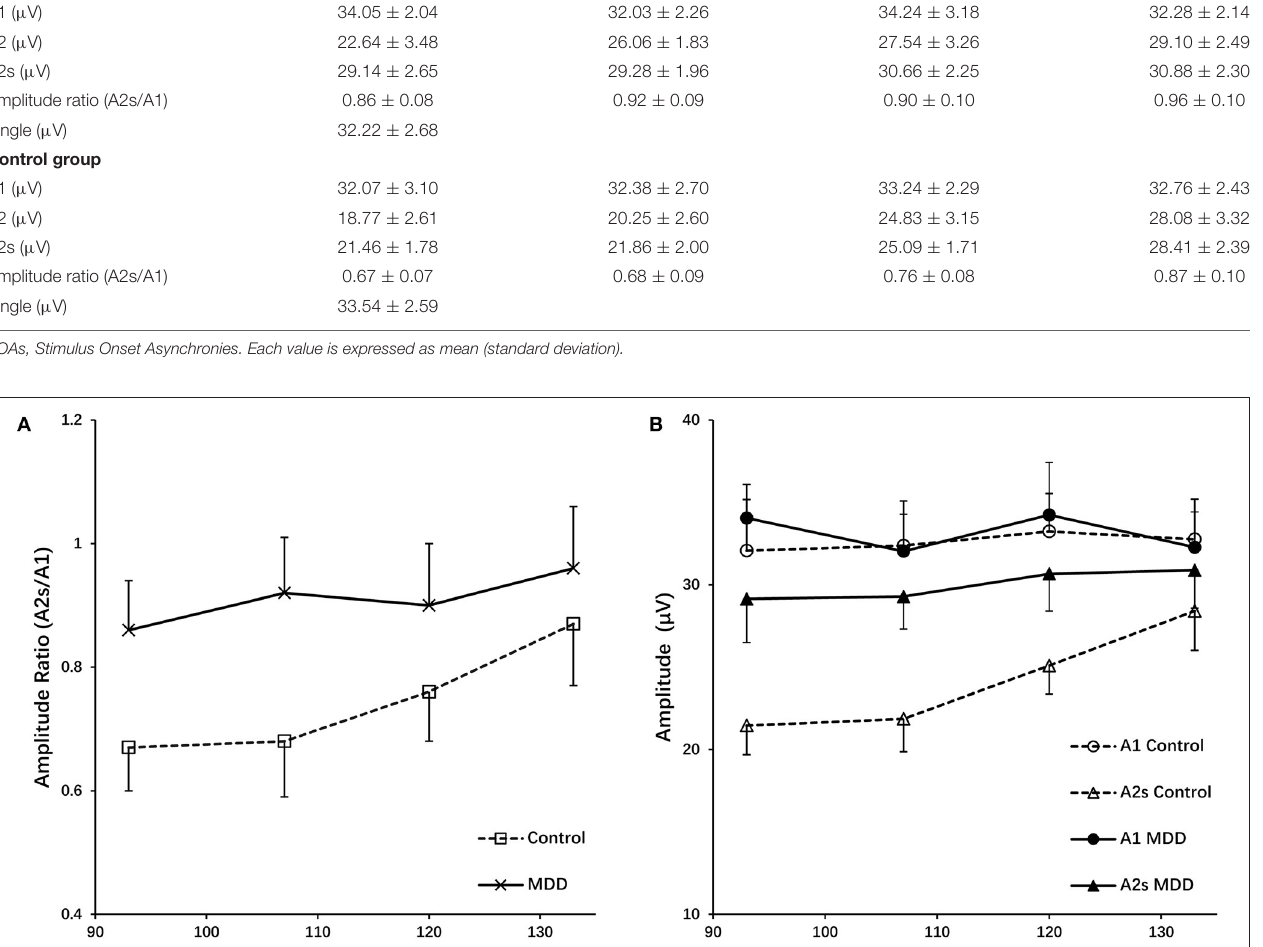
TABLE 2 | Response amplitudes and their ratios for the MDD group and healthy controls. Parameter SOAs (ms) 93 107